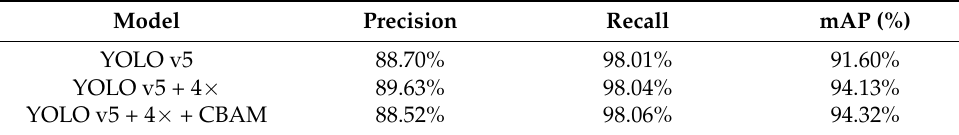
Table 6. Different algorithms for wheat ear detection. Model